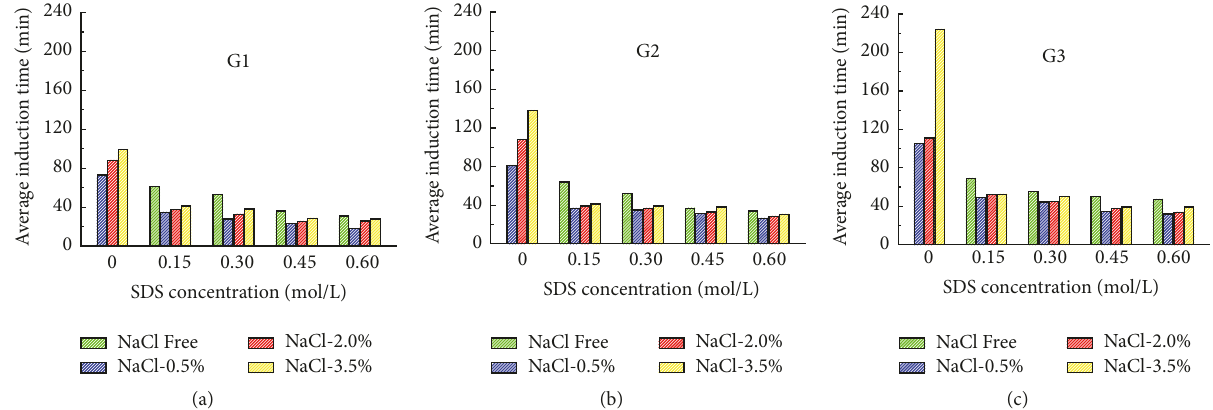
Figure 6: The induction time distribution of gas hydrate formation in different gas groups with the changing of SDS concentration.